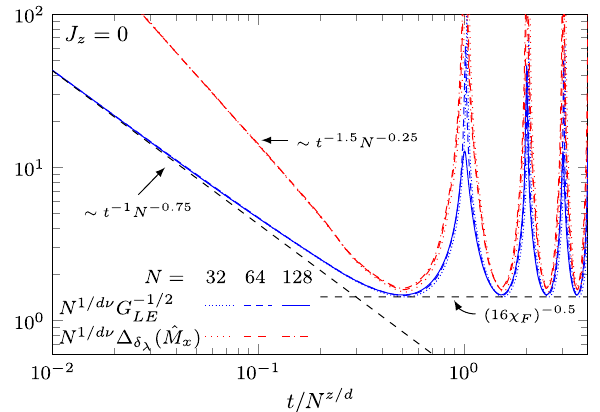
FIG. 3. Time dependence of QFI at the critical point in the XXZ model, which results from a small instantaneous shift of the external magnetic field, i.e., the Loschmidt echo. The time is rescaled by the system size according to Eq. (15). The maximal value which can be reached by QFI is bounded by the ground- state fidelity susceptibility (dashed line). We rescale QFI (blue ¼ 0 , z=d ¼ 1 and lines) according to Eq. (11). Here, for J z d ν ¼ 4 = 7 . For short times, G 1 = 2 ∼ tN 1 − ½ h (cid:2) =d , marked with dashed line, with 1 − ½ h (cid:2) =d ¼ 3 = 4 in our case. For evolution time t ∼ N z=d , QFI almost reaches it maximal value and later exhibits periodic revivals characteristic for the Loschmidt echo. We also ˆ M show the time dependence of the precision allowed by (red x lines). For long time it is close to optimal, mimicking the behavior of QFI. For short times it is suboptimal. In that case, Δ ð ˆ M ; λ ; t Þ ∼ t − 1 . 5 N − 0 . 25 is below the shot-noise limit as a δ λ x c function of N ; see Eq.